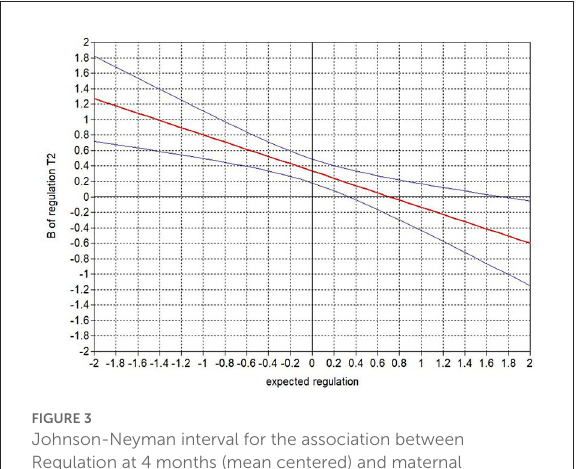
FIGURE3 Johnson-Neyman interval for the association between Regulation at 4 months (mean centered) and maternal responsiveness, at the different levels of expected Regulation (mean